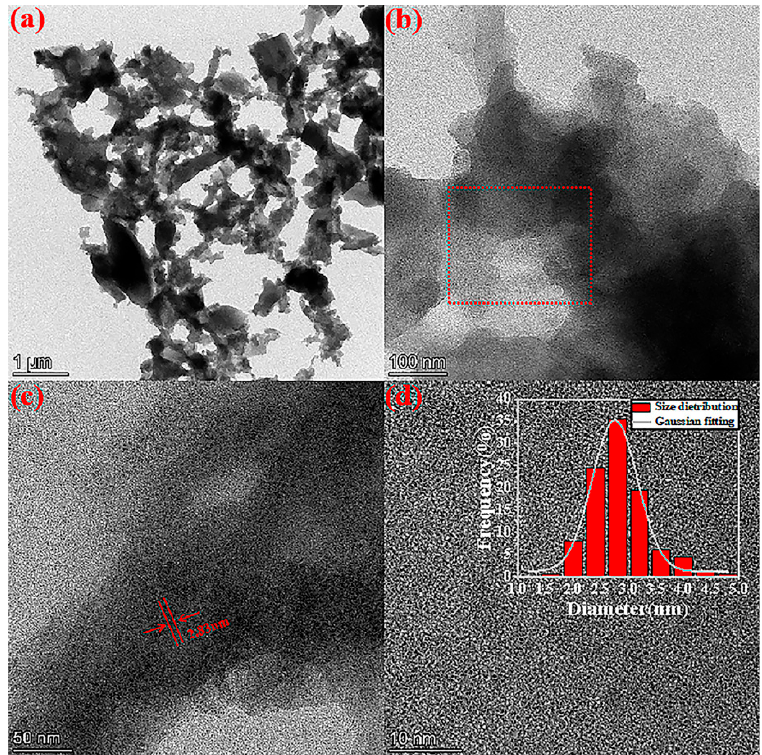
Figure 6. ( a – c ) HRTEM images of MFN-1.5 under different magnifications; ( c ) enlarged from the red rectangular area in ( b ); ( d ) the lattice diagram obtained from the HRTEM images; (insert) particle-size distributions of γ -Fe 2 O 3 . Two hundred particle sizes were counted.